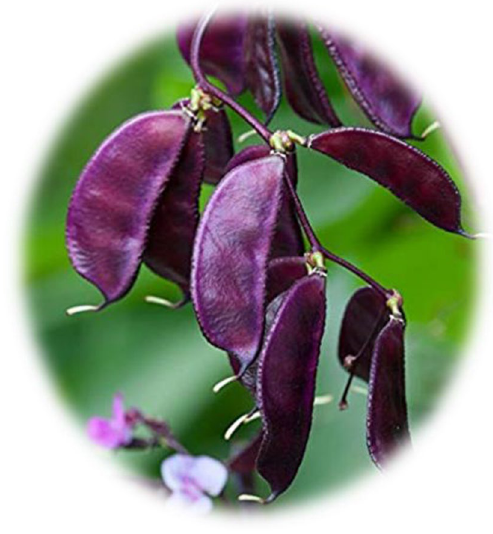
Fig. 13 Seed gum of Dolichos lablab as coagulant